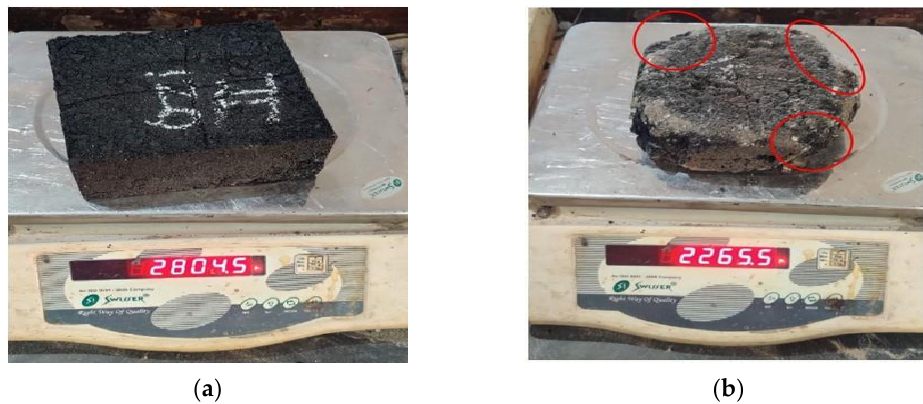
Figure 5. Block specimen ( a ) before testing; ( b ) after testing, showing loss of material marked by red circles. Table 7. Average Rut Depth (mm).